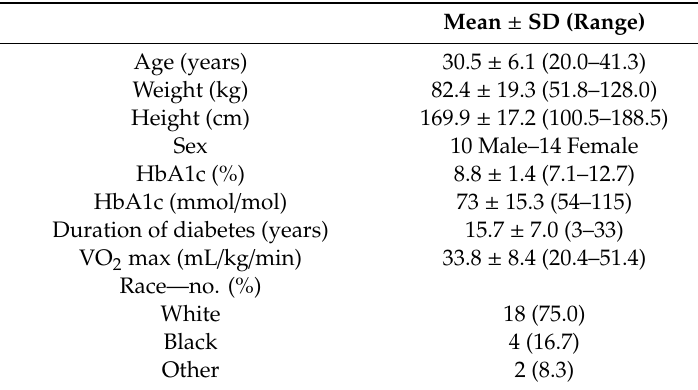
Table 1. Participant demographics and baseline